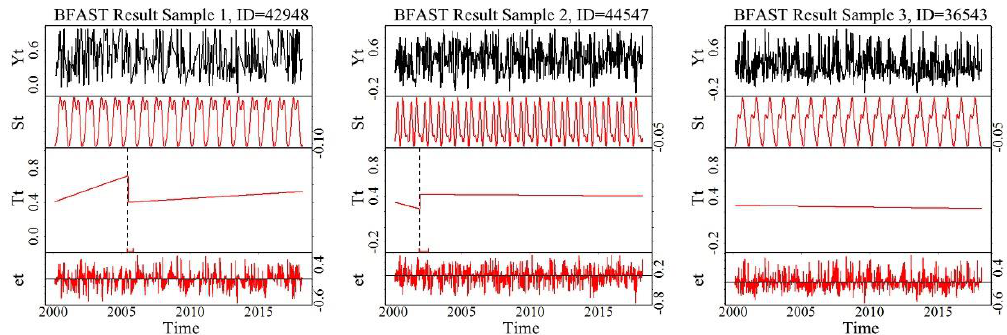
Figure 4. Plots of NDWI time series and BFAST-decomposed seasonal, trend, and remainder components and BFAST-detected break points of samples in water areas without damming activities in the period of NDWI time series. These sampled plots showed that the values in trend component before the break points (if detected) are higher than those in land-to-water pixels.